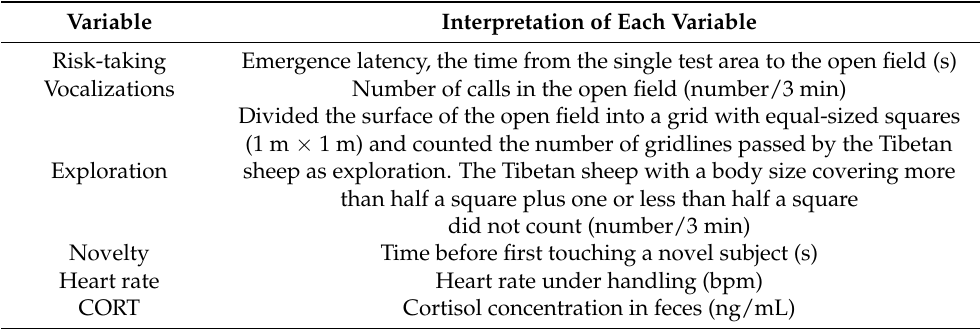
Figure 1. Diagram showing the experimental conditions of the test arena. Table 1. Description of the behavioral and physiological traits of Tibetan sheep ( Ovis aries